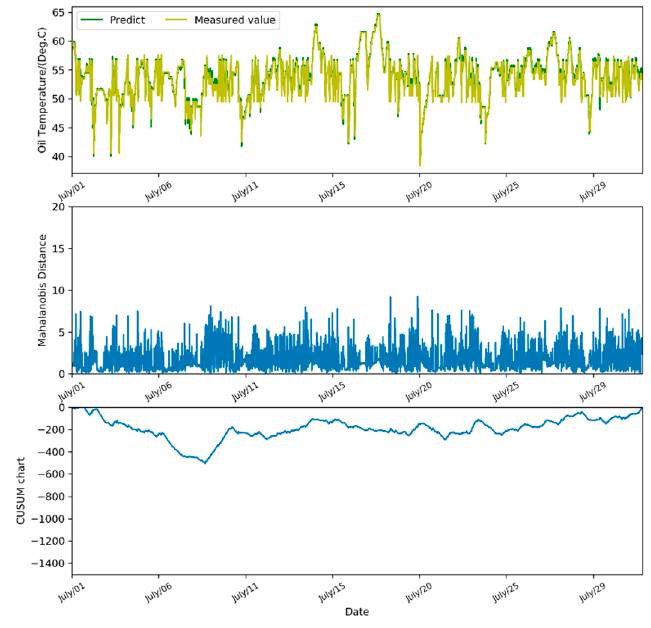
Figure 8. Testing normal behavior model results for Turbine #36.